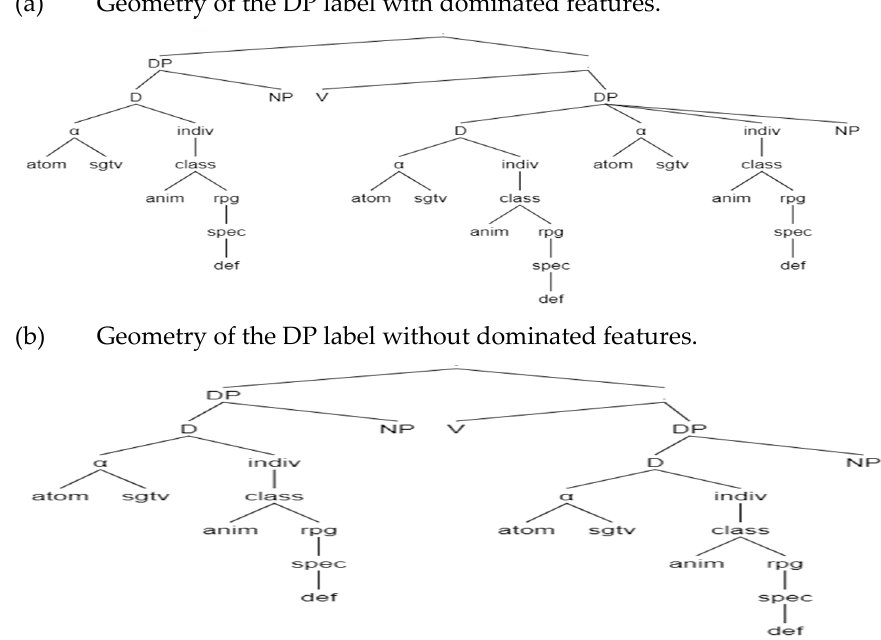
Figure 13. Geometries of the DP.